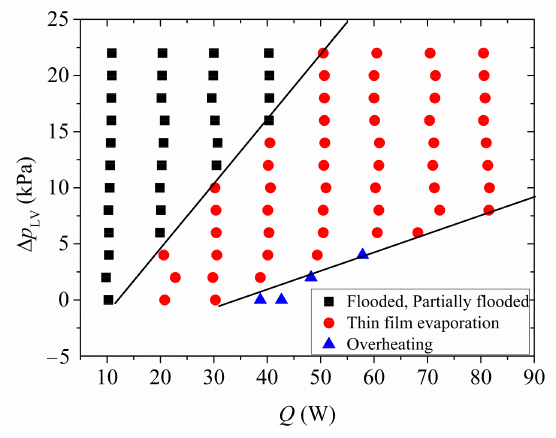
Figure 6. Two-dimensional heat transfer mode distribution diagram.